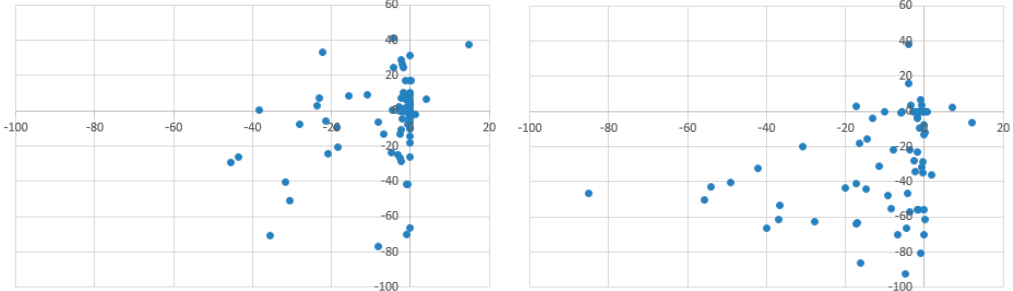
Figure 3. Relationship between percent change in cropland (y-axis) and fallow land (x-axis) in each municipality of the study area with at least 0.1 ha cropland in 1993 ( left : 1993–2006; right : 2006–2015).